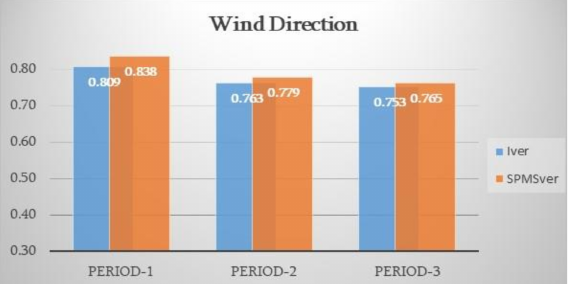
Figure 8. Illustration of the medians of the index of agreement values for the wind direction of the Iver (in blue) in comparison to the SPMSver (in orange) for the three meteorological periods.